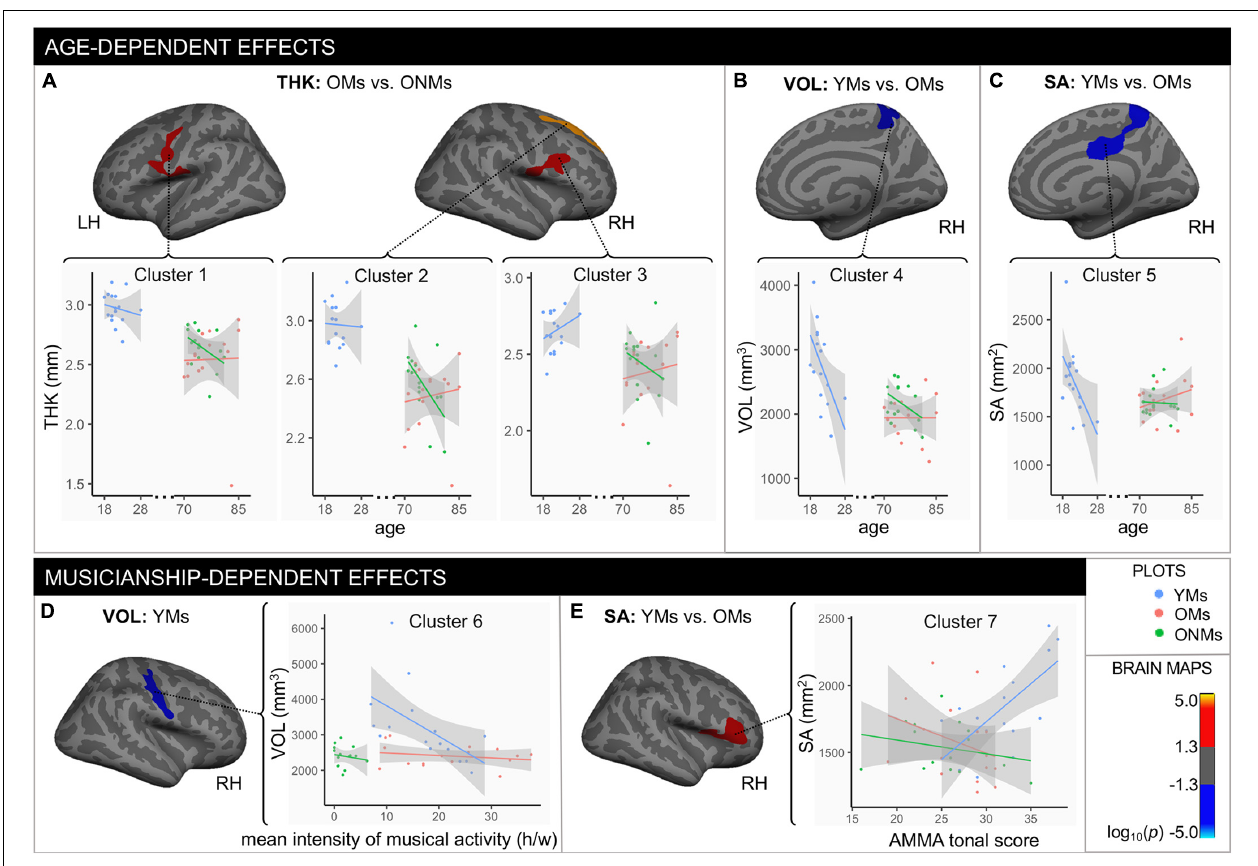
FIGURE 3 | Age- and musicianship-dependent structural differences. Age-dependent effects: clusters that showed significant changes with age in (A) thickness, (B) volume, and (C) surface area between the specific groups (output from FreeSurfer age-slope difference analysis). Musicianship-dependent effects: (D) cluster that showed significant association between the mean intensity of musical activity (h/w) and volume in the YMs (results from covariance analysis); (E) cluster that showed significant surface area differences between the YMs and the OMs with changes in AMMA tonal score (output from FreeSurfer AMMA-slope difference analysis). All depicted clusters evolved from the general linear model (GLM) analysis. The multiple comparison correction method is Monte Carlo 10,000 simulations with a setup clustering threshold of log10( p -value), which was set at p = 0.05; hence the color bar indicates positive (red/yellow) vs. negative (blue/turquoise) significant values. Cluster details can be found in Table 2 . Note that the depicted brain clusters only refer to specific group differences found in the GLM (age-slope analysis: A–C ; covariance analysis: D ; AMMA-slope analysis: E ), while the scatterplots include values for all the three groups. Scatterplots that included all the three groups were only inserted for descriptive purposes and better readability of the data and were not part of the GLM analysis. The gray area around the lines represents the 95% confidence level interval for predictions from a linear model (“lm”). YMs, young musicians; OMs, old musicians; ONMs, old non-musicians; THK, thickness in mm; VOL, volume in mm 3 ; SA, surface area in mm 2 ; LH/RH, left hemisphere/right hemisphere; AMMA, Advanced Measures of Music Audiation test; y, years, h/w,